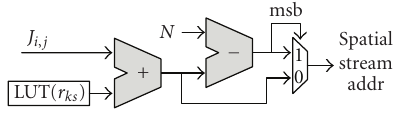
Figure 9: HW for frequency rotation in 802.11n.